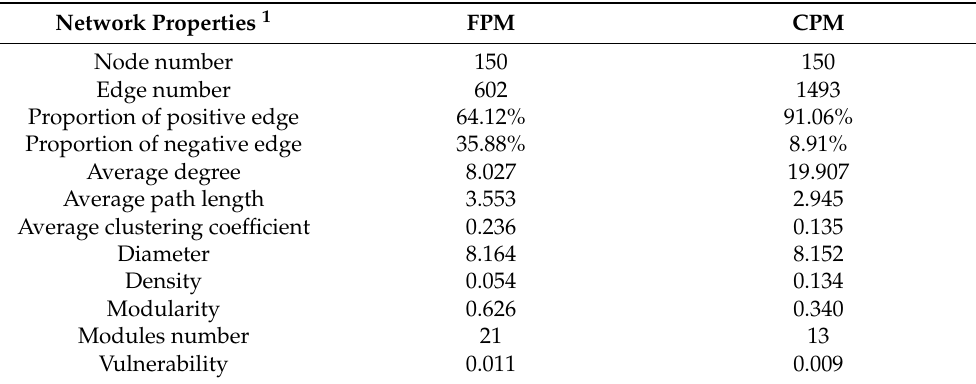
Table 1. The global topological properties of co-occurrence